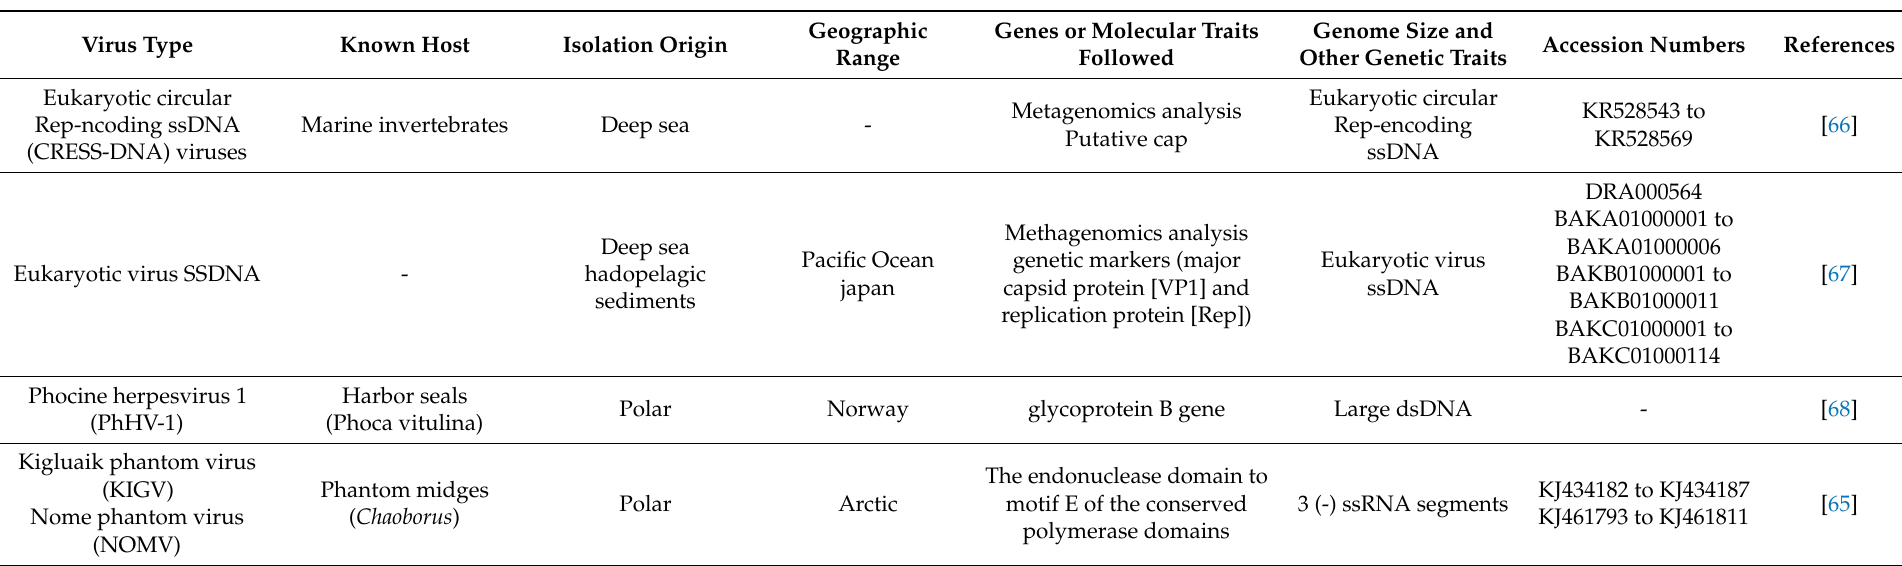
Table 3. Virus in extremophile